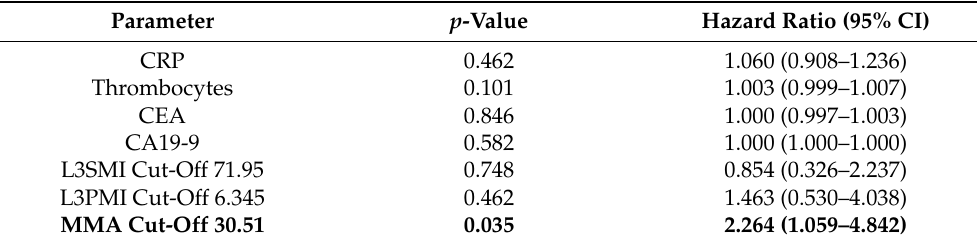
Table 3. Multivariate Cox regression analysis for the prediction of overall